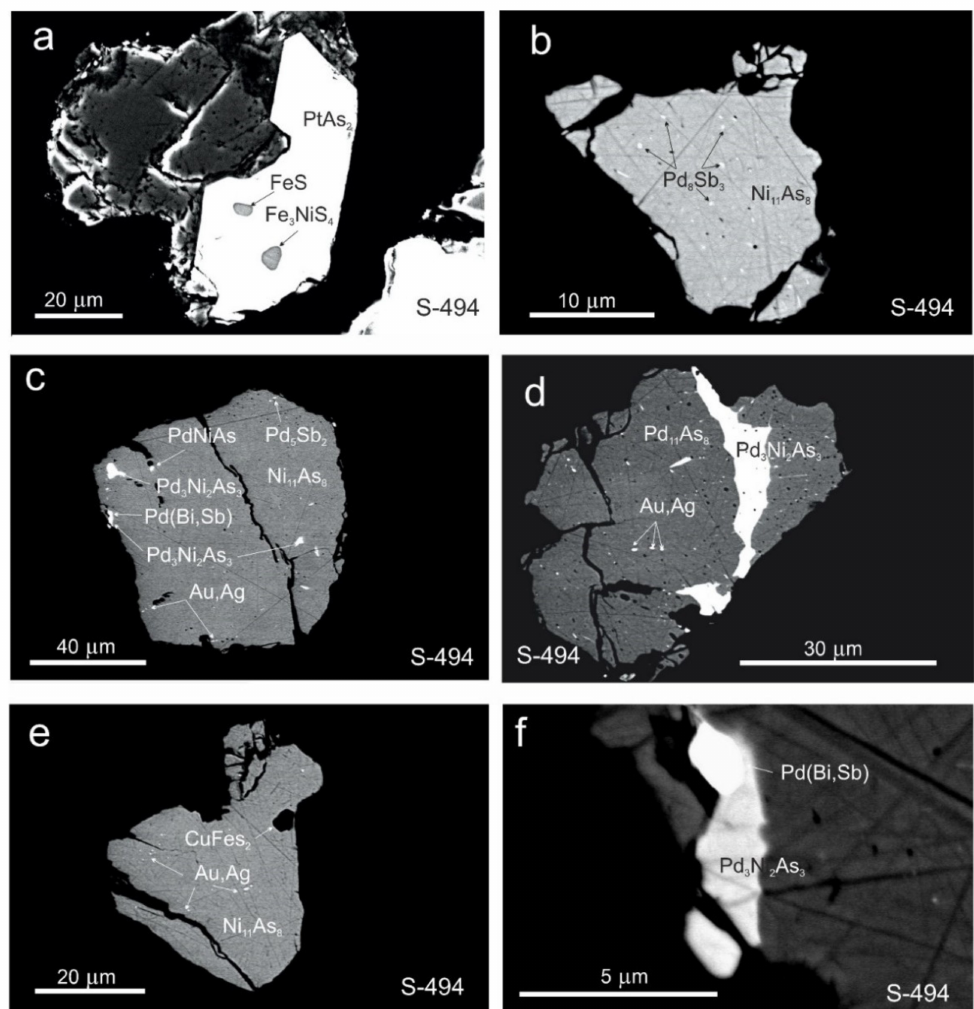
Figure 7. Morphology and microparageneses of PGM from samples of borehole S-494, SEM image: ( a ) crystals of sperrylite PtAs 2 with droplet-shaped inclusions of pyrrhotite FeS and Fe-SS (Fe 3 NiS 4 ); ( b – e ) maucherite grains with tiny inclusions of mertieite II Pd 8 As 3 ( b ), menshikovite Pd 3 Ni 2 As 3 , majakite PdNiAs, stibiopalladinite Pd 5 Sb 2 , sobolevskite Pd (Bi,Sb), and gold (Au,Ag) ( c – e ); ( f ) grains of maucherite intergrown with menshikovite and